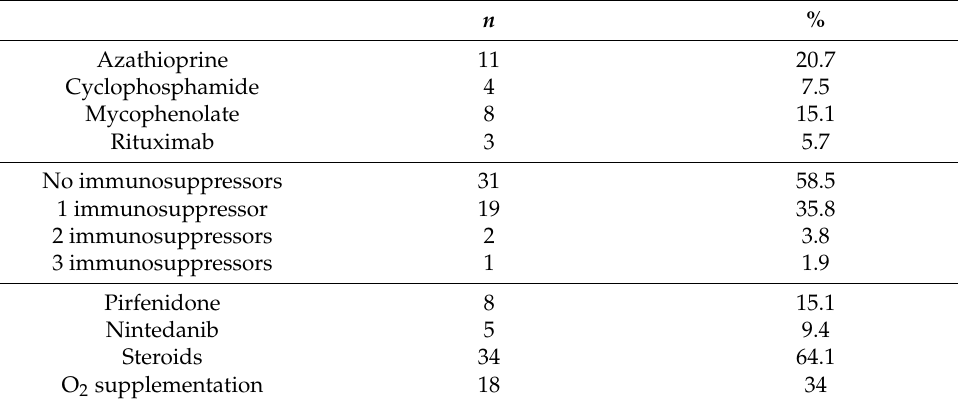
Table 2. Proposed treatments in 58 anti-MPO-ILD